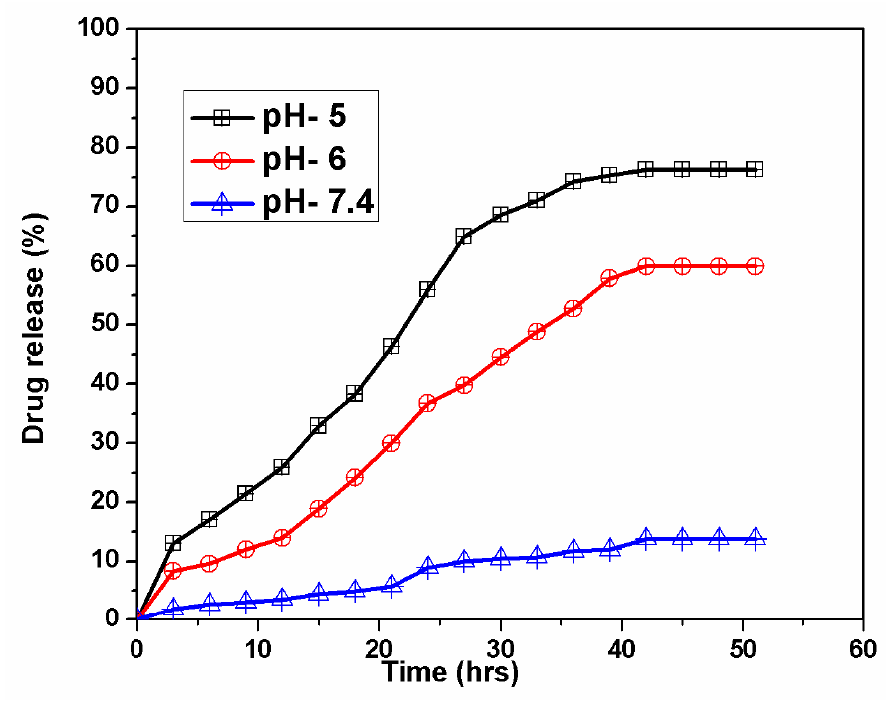
Figure 6. Cumulative drug release of methyl gallate at different pH (5, 6 and 7.4).